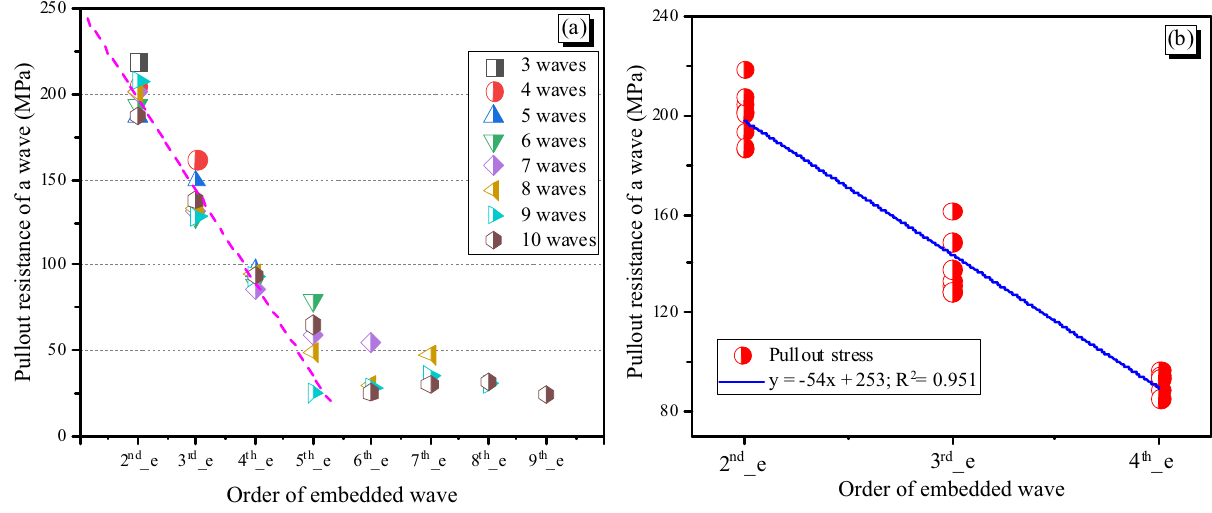
Figure 25: Pullout stress of each wave with various numbers of embedded waves. ( a ) Value of unit pullout resistance per wave, ( b ) Linear relationship between the unit pullout resistance per wave and the last four